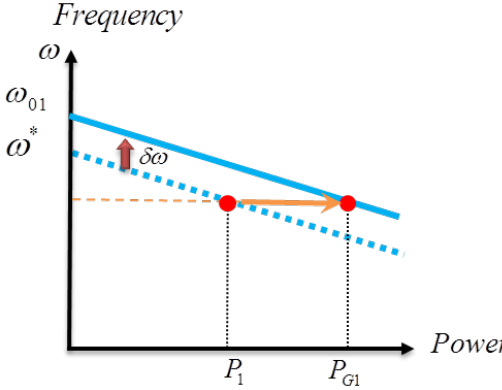
Figure 3. Illustration of power regulation principle by frequency scheduling.